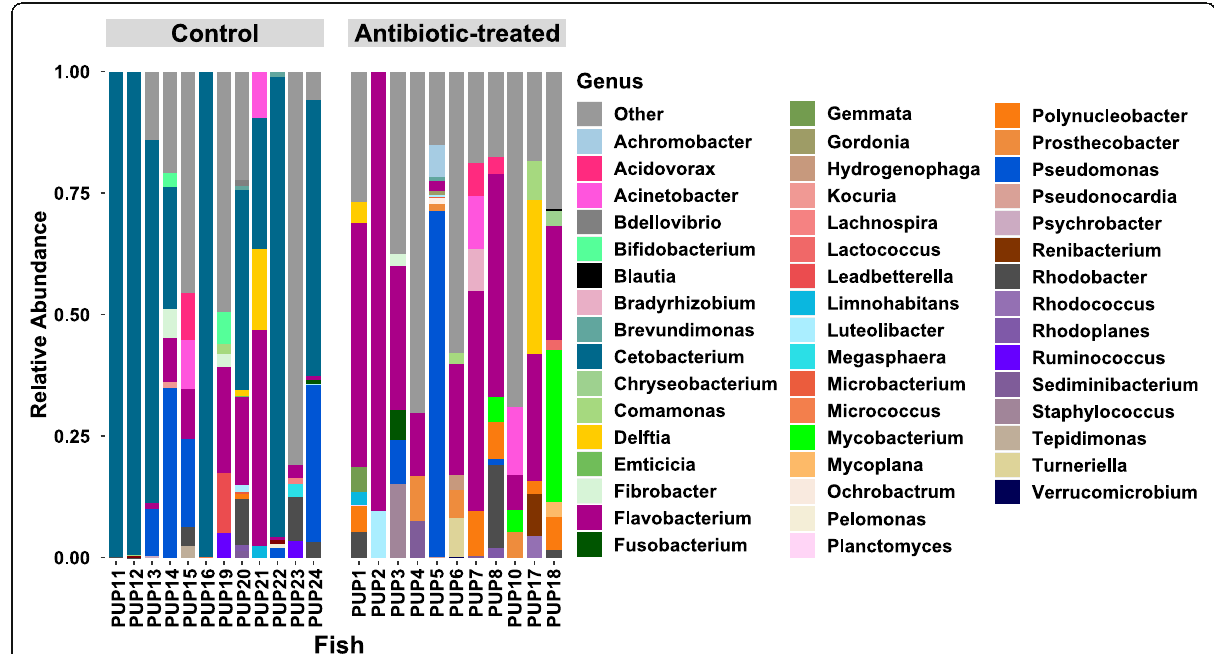
Fig. 4 Genus-level relative abundance of 129 ASVs that are predicted to encode alcohol dehydrogenase. These ASVs are predicted to have alcohol dehydrogenase activity. ASVs with no predicted alcohol dehydrogenase are indicated as Other